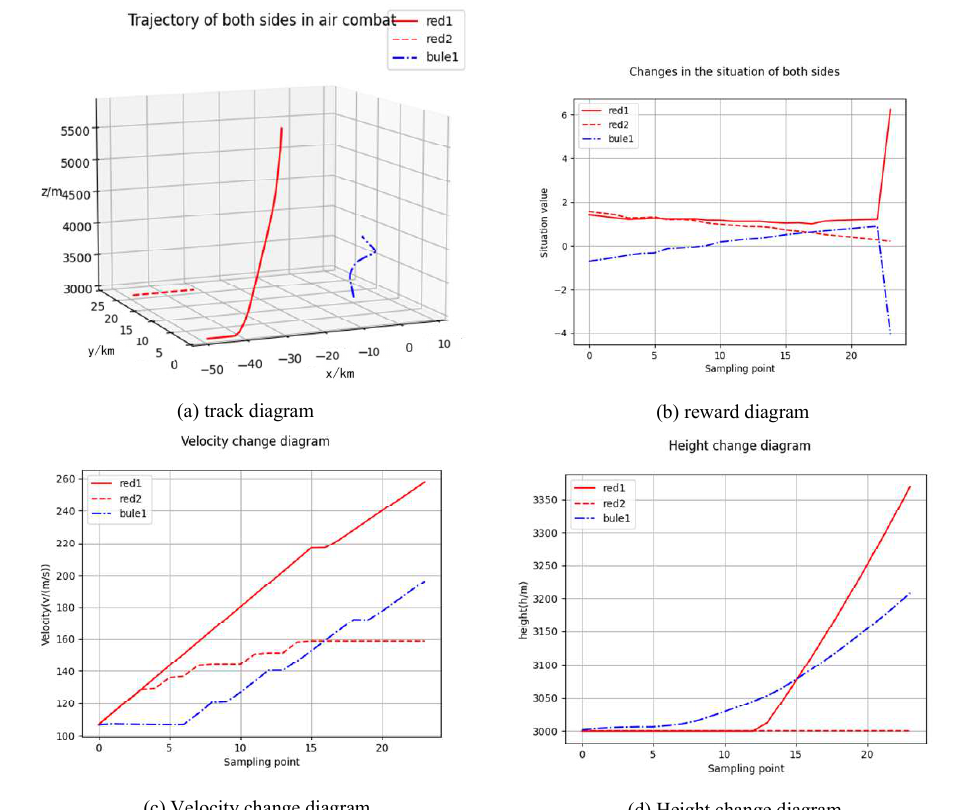
Figure 7. Simulation 1 of red 1 hitting the blue UCAV.